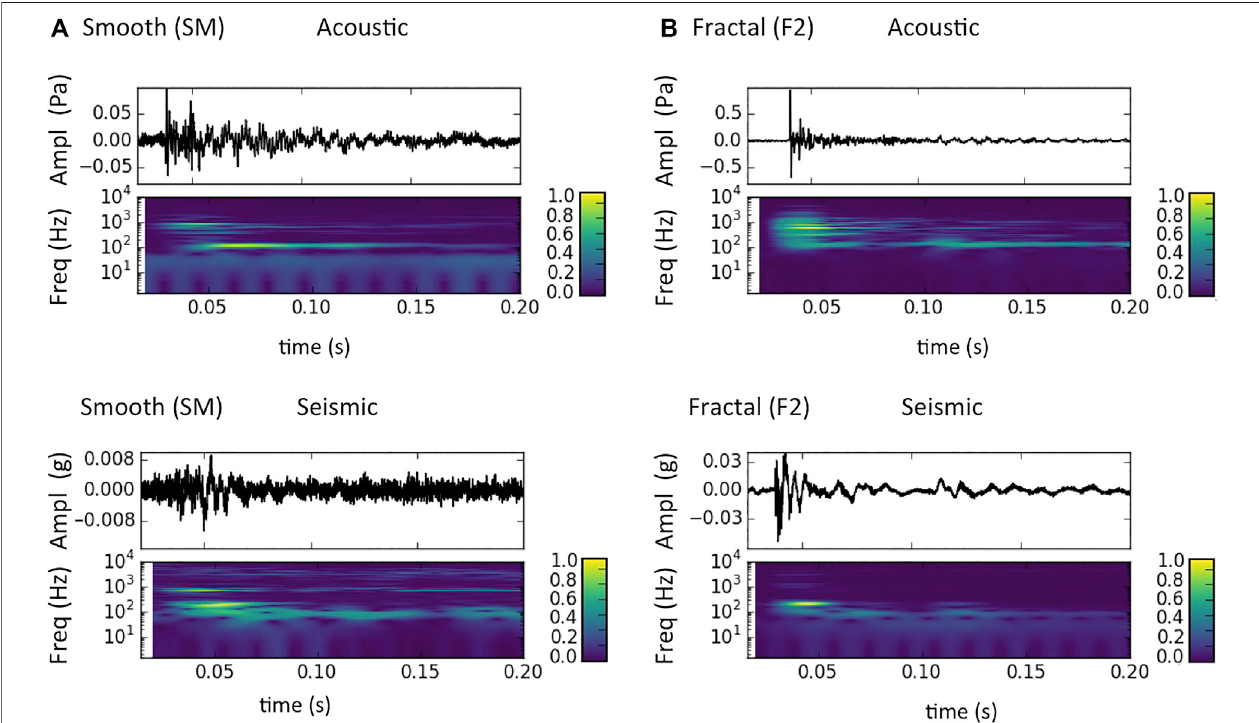
FIGURE 2 | Comparison between the raw signal and the spectrogram of a seismo-acoustic event generated with a smooth SM-type conduit, viscosity (cid:2) 10 Pa s, fl ow velocity (cid:2) 120 × 10 – 3 l/s (A) , and an event generated with a F2-type conduit, viscosity (cid:2) 10 Pa s, fl ow velocity (cid:2) 120 × 10 – 3 l/s (B) .